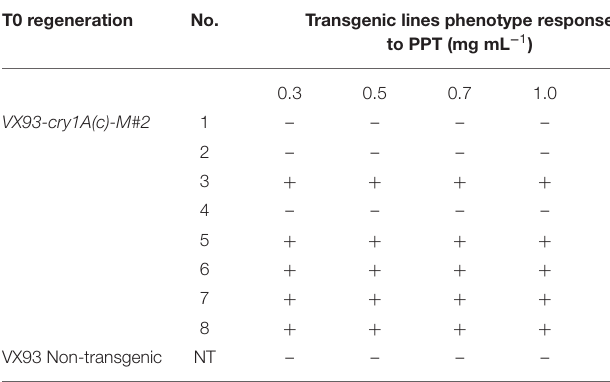
TABLE 2 | Evaluation of the transformation efficiency of VX93- cry1Ac-M#2 in T0 herbicide-resistance gene ( bar ) by testing phosphinothricin (PPT). T0 regeneration